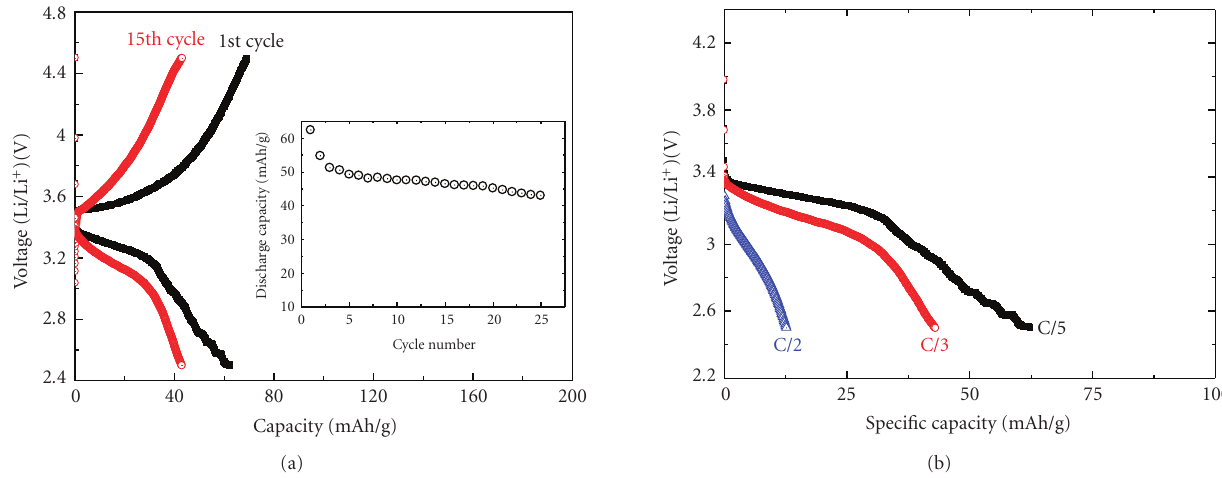
Figure 6: (a) Charge/discharge profile of LiFePO 4 sample without carbon source and inset discharge up to 25 cycles; (b) discharge profile of LiFePO 4 sample with carbon source at discharge rate of C/5, C/3, and